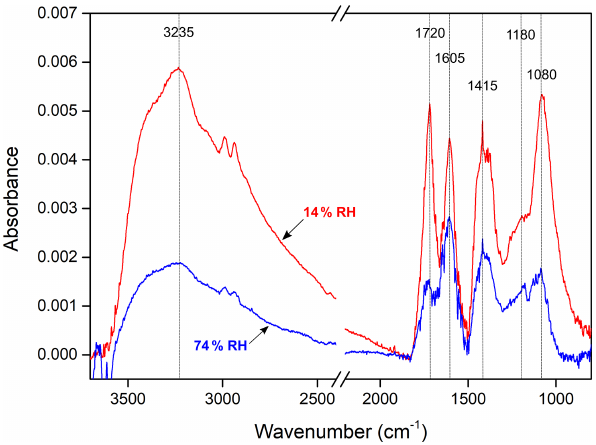
Figure 3. FTIR spectra of particles from photooxidation of m - xylene–OH experiments under 14% (Exp. 2) and 74% RH (Exp. 8) conditions.